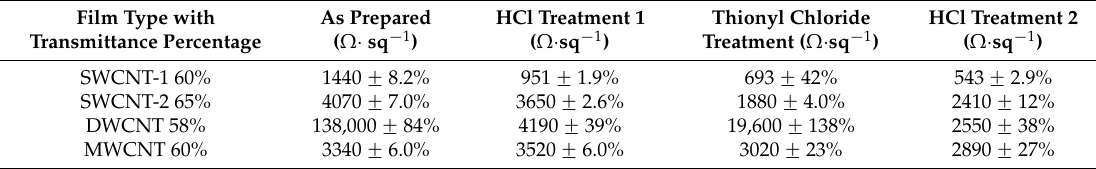
Table 3. Average sheet resistance for each carbon nanotube (CNT) sample with treatment ( Ω ¨ sq ´ 1 ). Film Type with Transmittance